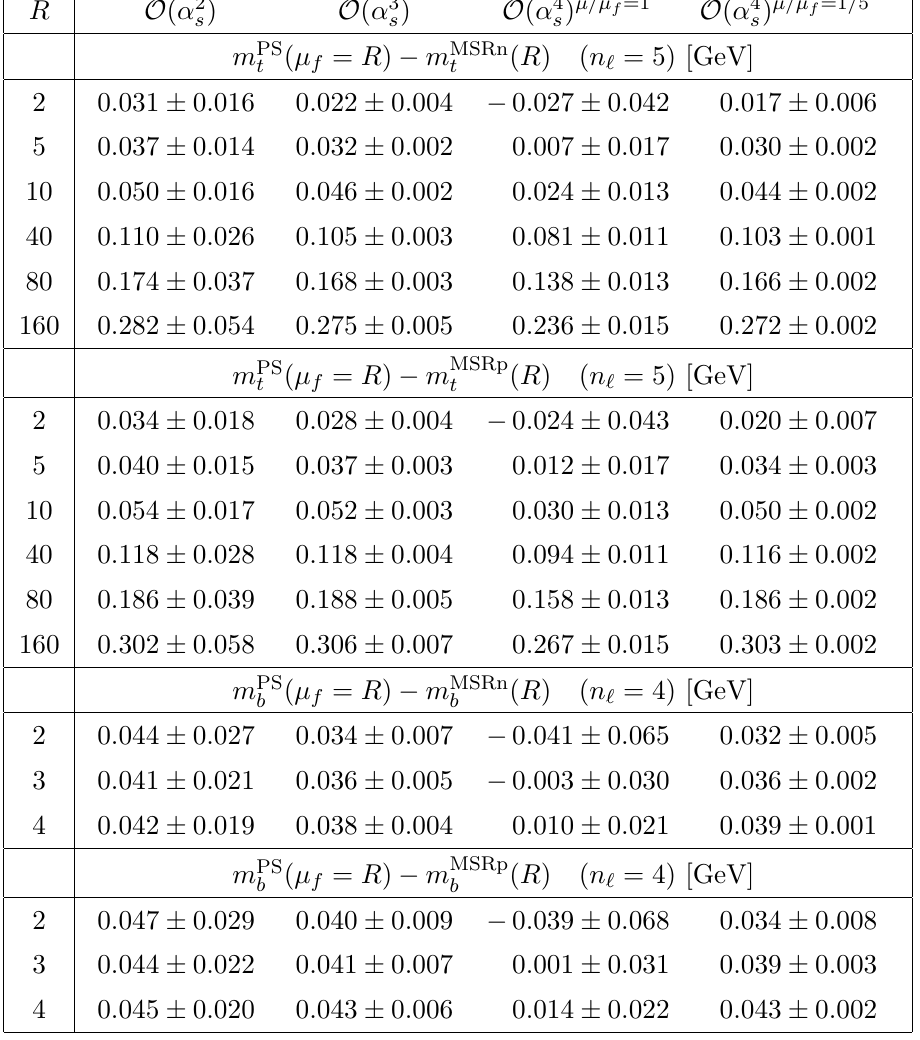
Table 4. Di(cid:11)erences between the top mass in the PS and MSR schemes, showing both the natural and practical MSR mass de(cid:12)nitions. Results are given for various scales (cid:22) f = R and orders in (cid:11) s . At O ( (cid:11) 4 ) results are shown for two choices of the infrared subtraction scale, (cid:22)=(cid:22) f = 1 and s (cid:22)=(cid:22) f = 1 =